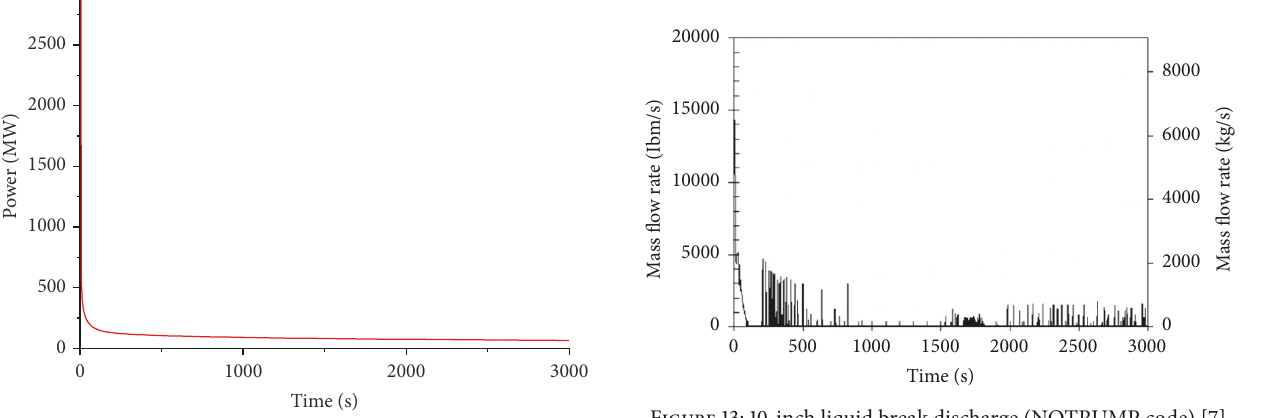
Figure 11: Nuclear power.